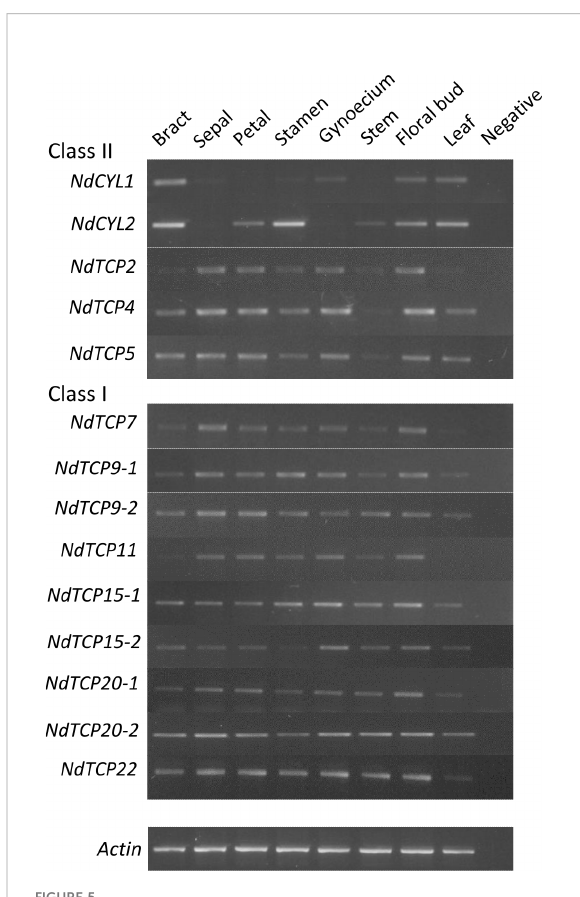
FIGURE 5 Expression patterns of all Nigella damascena TCP genes in eight aerial